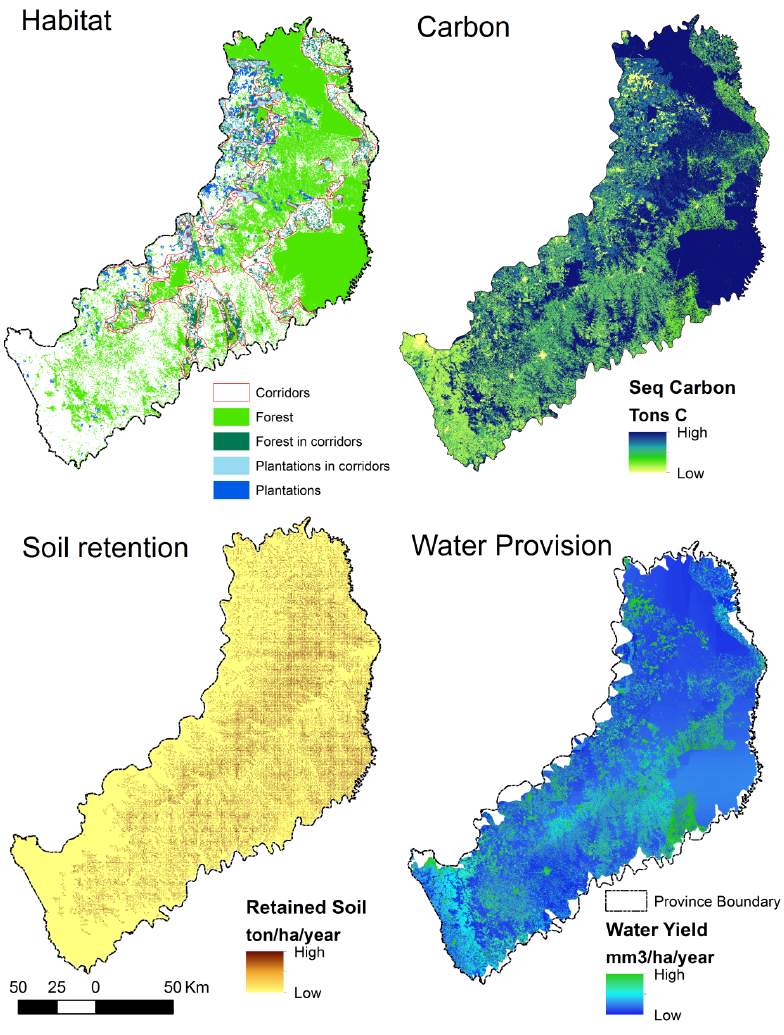
Figure 2. Maps of the analyzed ecosystem